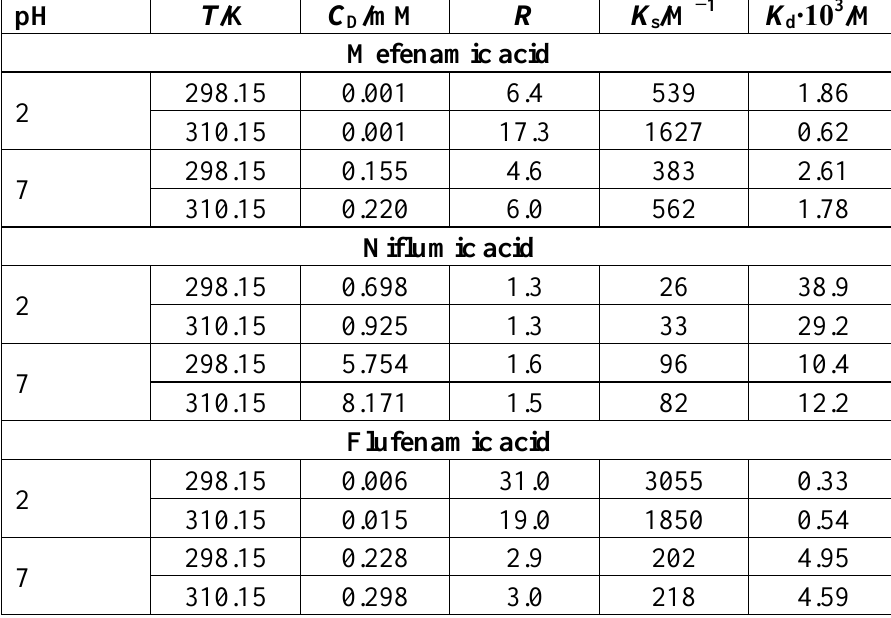
Table 1. The solubility ( C ) in water at two temperatures and two pHs (buffer solutions), calculated values of solubility enhance ratio ( R ), calculated values of cyclodextrin-drug complex stability constants K and dissociation constants K s d